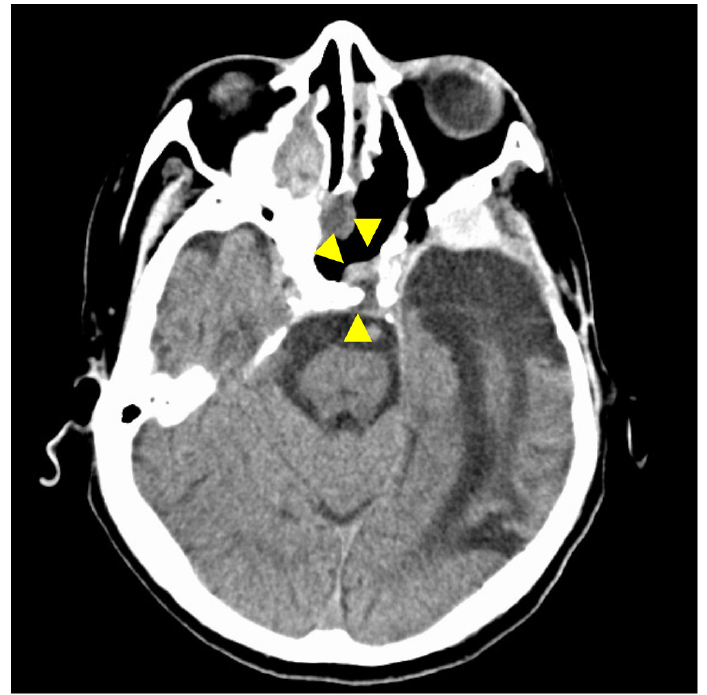
Figure 7. CT findings at 30 months after surgery. The isodense area at the tumor resection site shows no tendency to increase, and there is no evidence of recurrence on CT imaging. Arrowheads indicate the site of tumor removal. The isodensity in the left ethmoid sinus is due to chronic sinusitis.